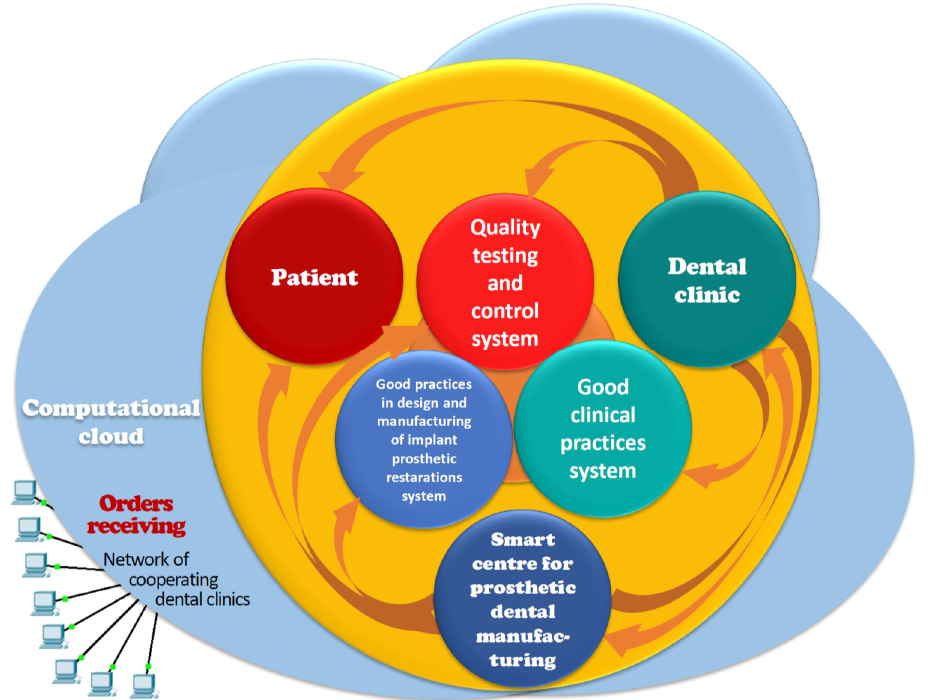
Figure 14. Diagram of the relationship between the medical tasks of the dental clinic, the design, and manufacturing capabilities of the dental prosthesis restoration center and the patient’s expectations according to the Dentistry 4.0 concept.